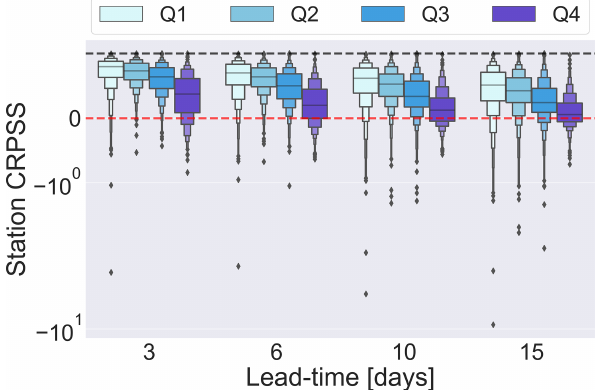
Figure 10. The CRPSS for all 522 stations calculated over the fore- casts (approximately 52 forecasts) with flow values in the lowest quartile (Q1) to the highest quartile (Q4). CRPSS values below 0 indicate the forecast probability distribution is on average less skil- ful after post-processing and values above 0 indicate added skill after post-processing. A log scale is used on the y